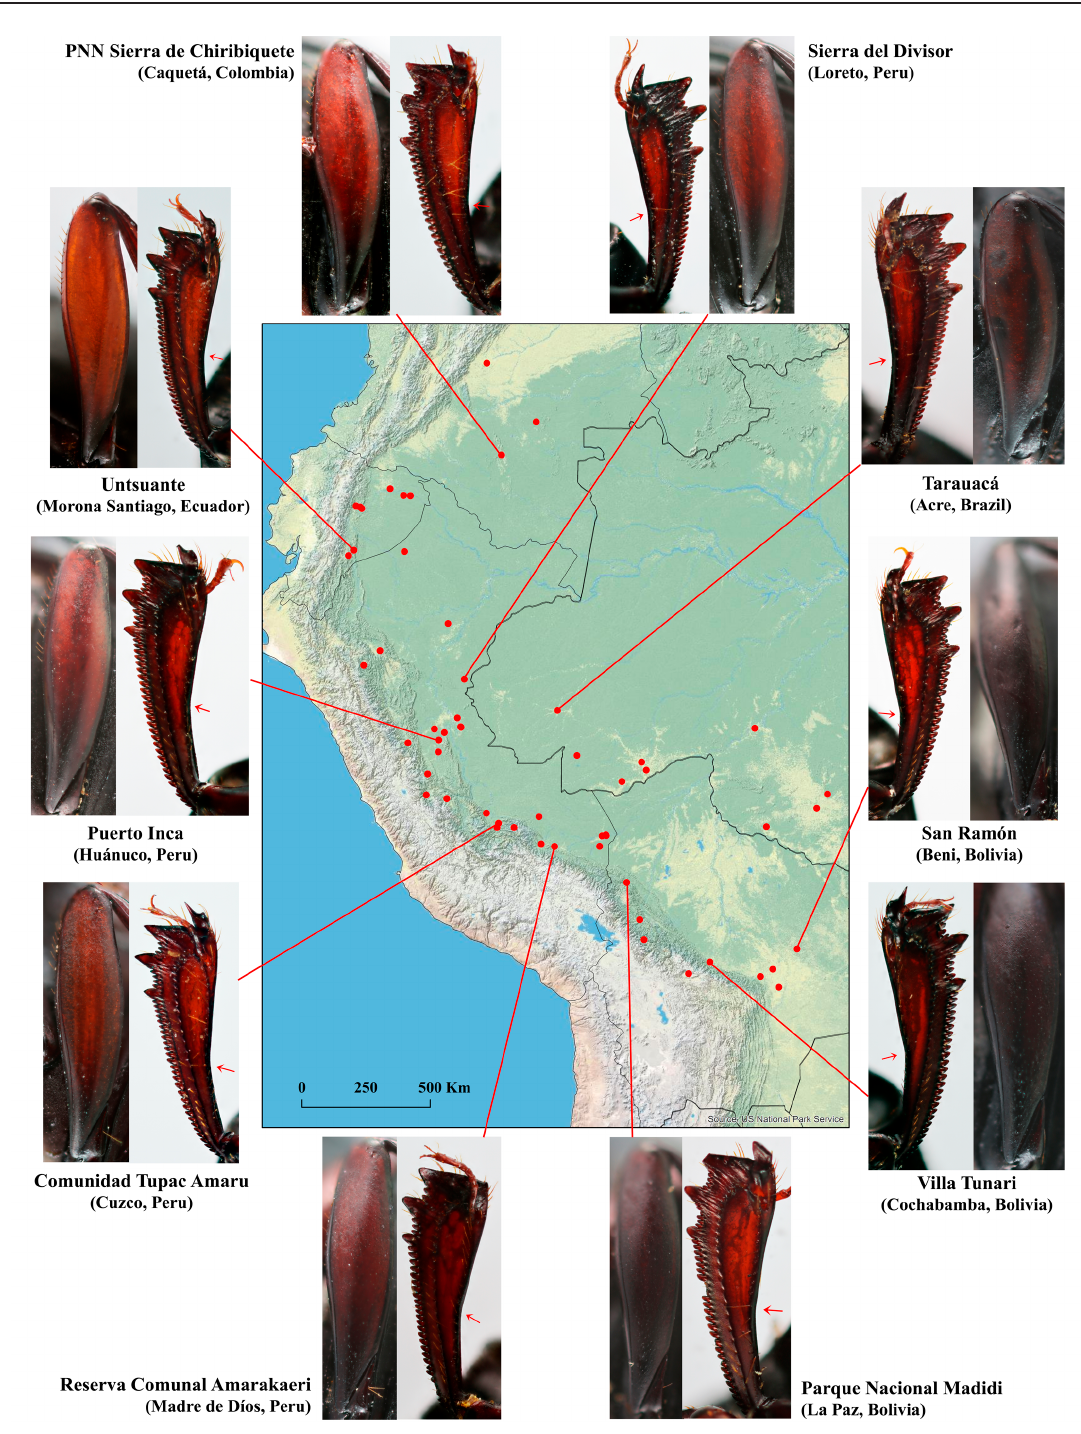
Fig. 36. Clinal morphological variation in S. bridarollii (Martínez, 1949). Note that, from south to north, the colouration of metafemora gradually fades from dark brown to reddish brown and orange with a light-brown base in populations of northern Peru, Ecuador, and Colombia, and that the internal margin of protibiae (indicated by the red arrows) becomes progressively much subtler. Other features varying along this north-south cline are the presence of coarse elongate punctures at the base of metafemora (present in southern populations and absent in the northern ones) and of a fine transverse line on the posterior edge of pronotum (absent in the southern populations). See the text for more